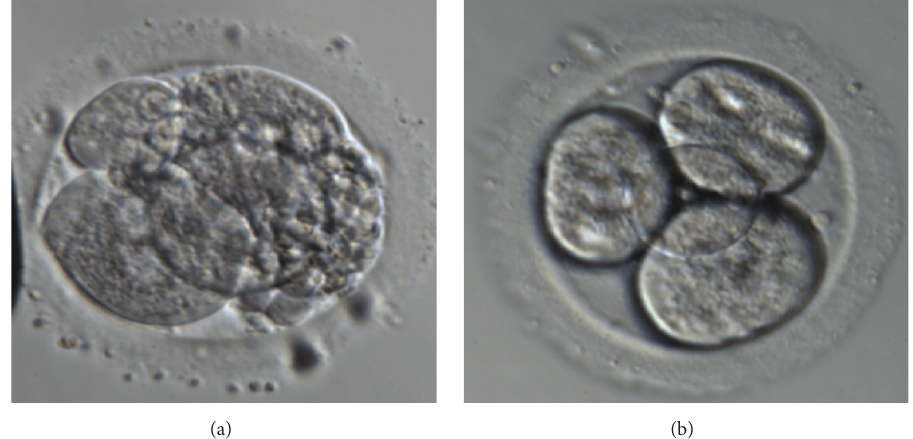
Figure 1: Cosmetic micromanipulation on cleavage stage embryo. (a) Embryo before cosmetic micromanipulation; (b) embryo after cosmetic micromanipulation.